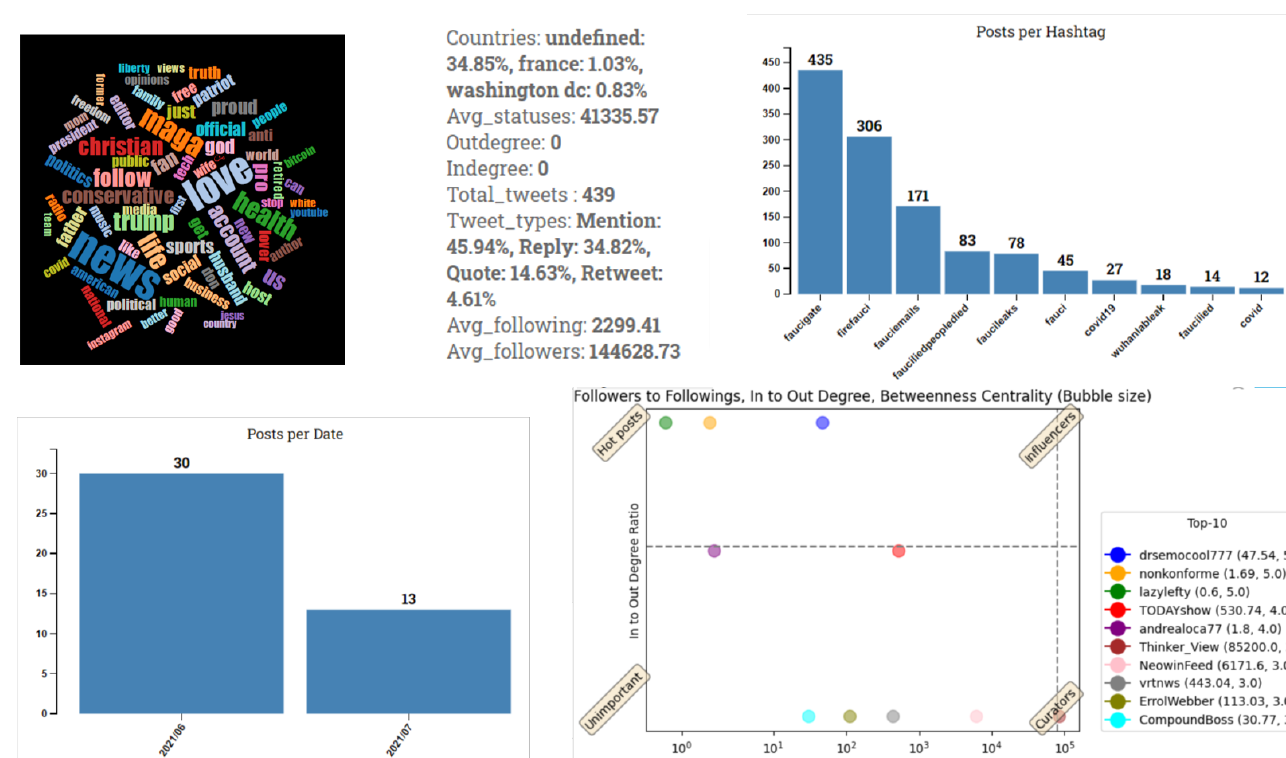
Figure 4. Community analytics: word cloud, user statistics, hashtag plot, tweet-posting plot, and centrality/influence scatter